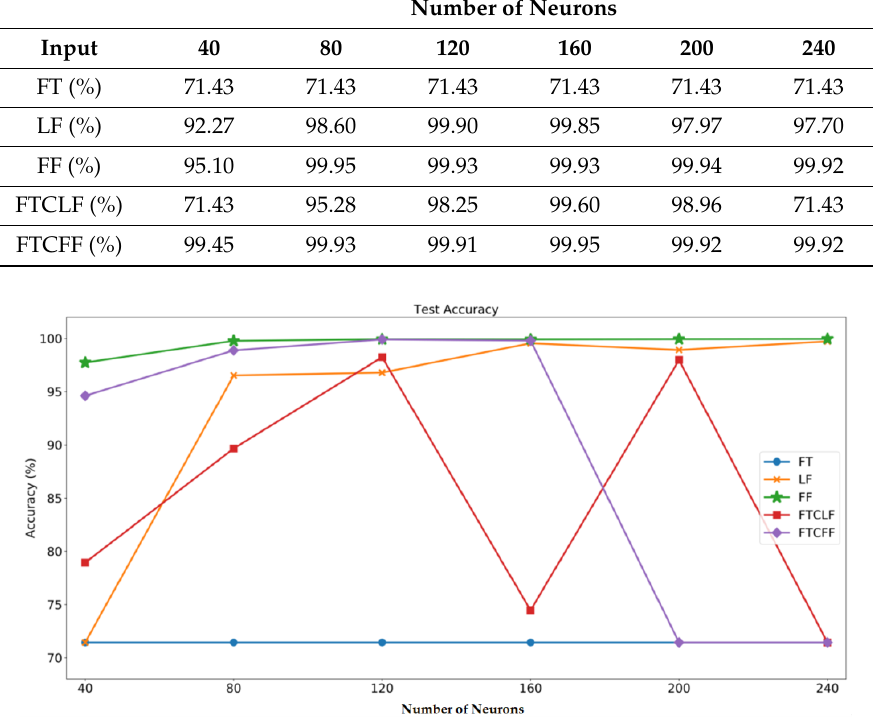
Figure 16. Accuracy results of the test set.